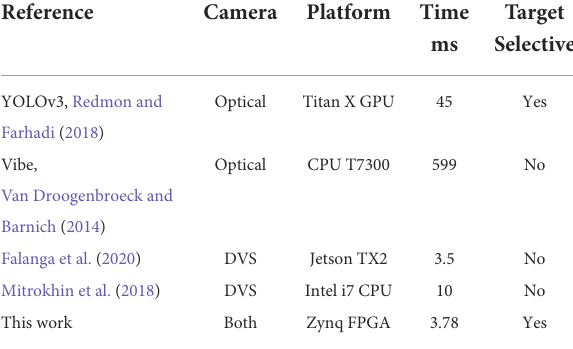
TABLE 1 Previous work on high-speed target